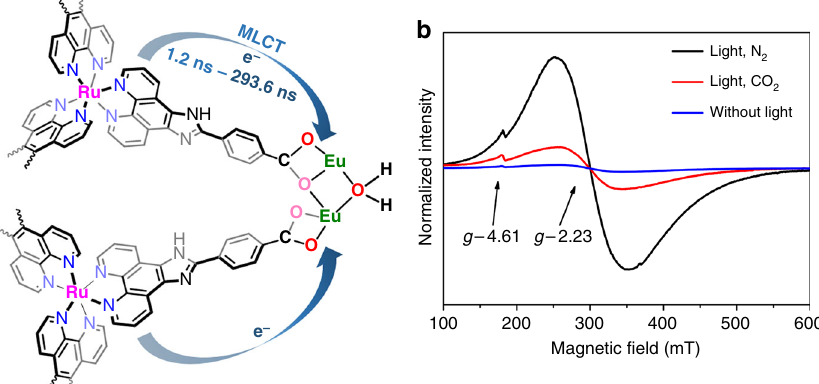
Fig. 5 Photocatalytic in situ EPR characterization. a Schematic light-induced dynamics of Eu-Ru(phen) 3 -MOF based on the initial excitation of the Ru photocenter and the pathways of electron transfer from Ru to catalytic Eu 2 oxo-cluster center. b In situ EPR spectra of Eu-Ru(phen) 3 -MOF under different conditions